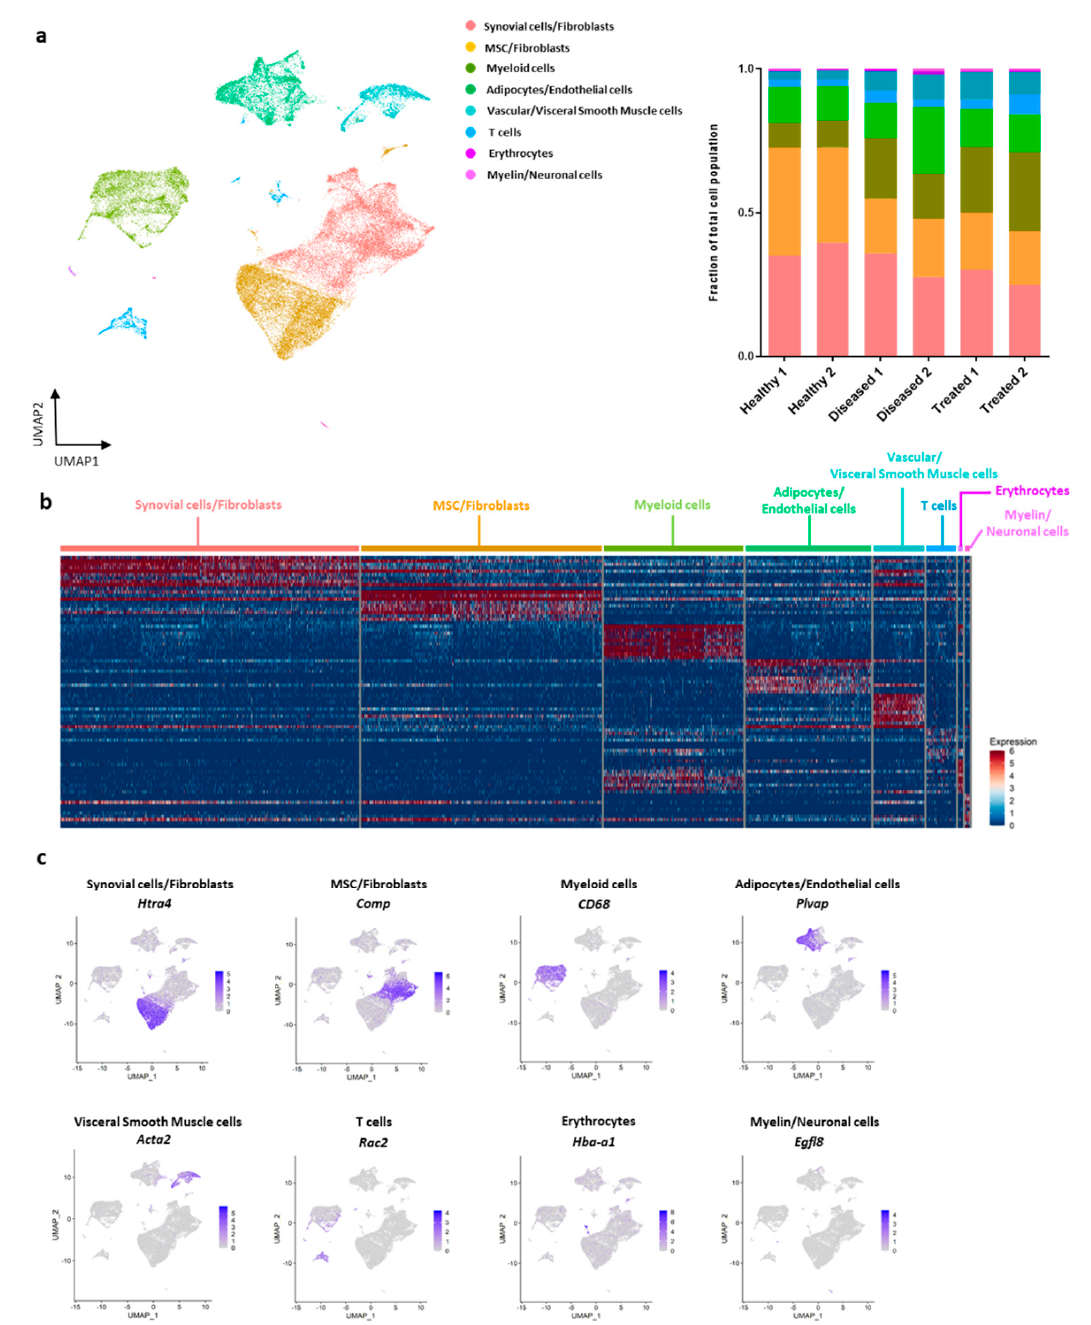
Figure 2. Single-cell RNA-sequencing clustering and analysis of IFP tissue. ( a ) Eight transcriptionally distinct cell populations were identified, with myeloid cells being one of the most prominent within the IFP tissue. Each point represents a single cell and separate subpopulations identified were color-coded. Cell population proportions revealed higher presence of myeloid cells within the IFP tissue in the MSC treated samples. Cell population proportions per sample were visualized by stacked bars plot. Healthy 1 and Healthy 2: healthy group replicates consisting of six rat knees each; Diseased 1 and Diseased 2: diseased group replicates consisting of six rat knees each; Treated 1 and Treated 2: treated group replicates (one injected with IFP-MSC1 and one injected with IFP-MSC2) consisting of six rat knees each. ( b ) Heatmap of top 10 marker genes defining each cell type. Each column represents a cell and each row a gene. High expression is red and lower expression is blue. ( c ) Gene localization plots identified specific canonical marker genes related to distinct cell populations. Gene expression levels depicted from gray (low) to purple (high).